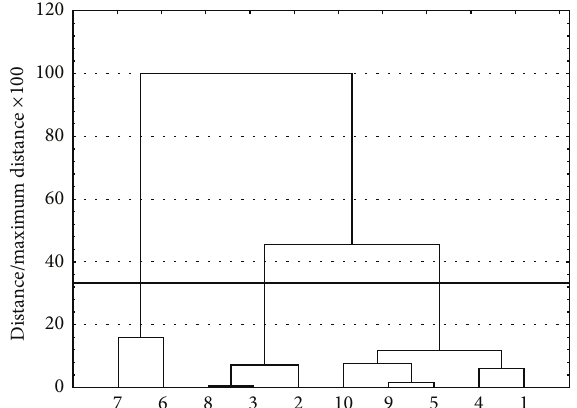
Figure 2: Hierarchical tree showing the assignment of objects (spectra) for each cluster (Ward method, Euclidean distances).